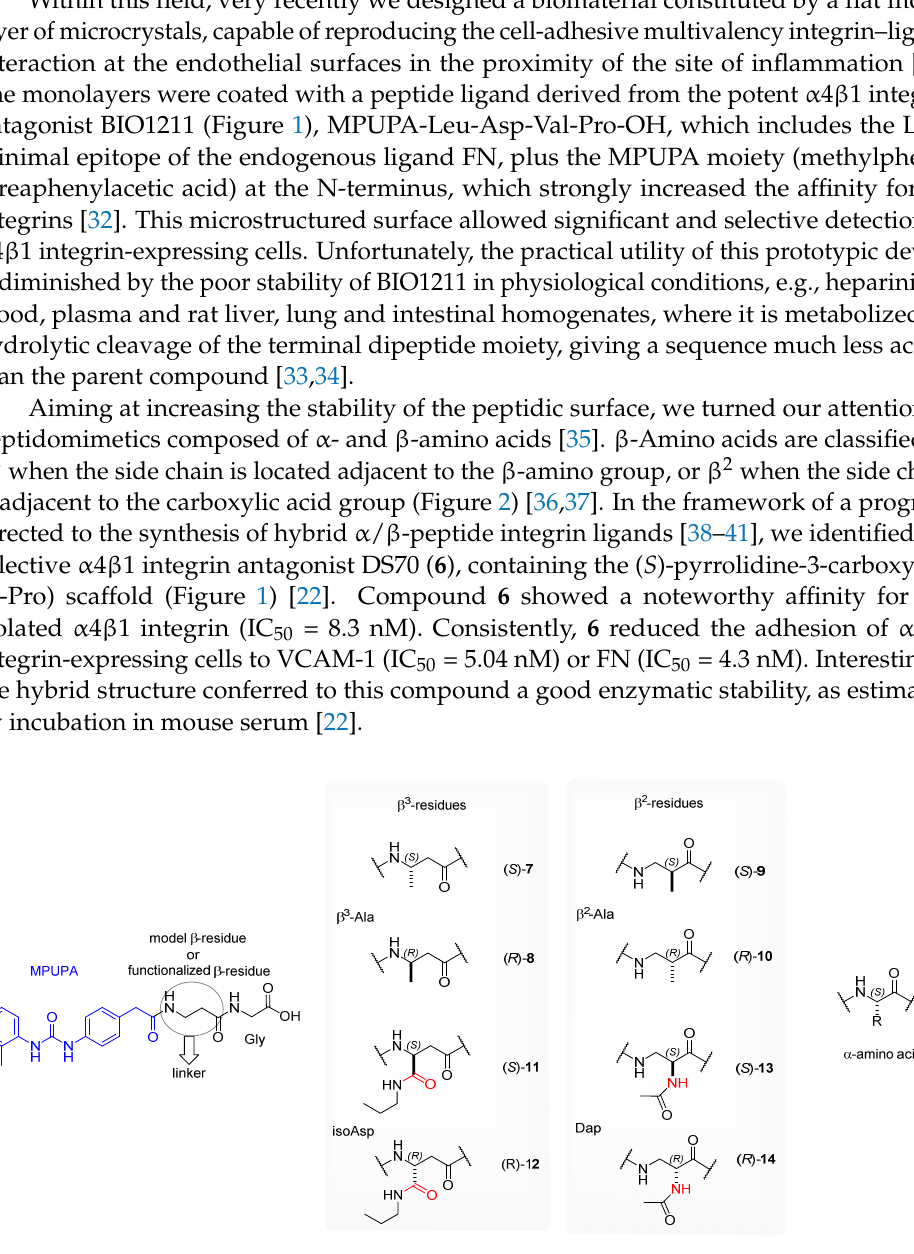
Figure 2. Sketches of candidate α 4 β 1 integrin ligands 7 – 14 based on a hybrid α / β -peptidic structure. In the boxes, model β 3 - or β 2 -aminoacids, i.e., β 3 -Ala and β 2 -Ala, and β 3 - or β 2 -residues carrying side chain functional groups suitable for diverse linker connections, i.e., isoAsp and Dap, respectively, are shown. Functional groups exploitable for peptide conjugation are rendered in red; these are terminated with n-propylamine in 11 and 12 , and with Ac in 13 and 14 . These results prompted us to design analogues of the hybrid α / β -peptide 6 con- taining diverse β -amino acid cores, equipped with versatile functional groups for ex- pedient connection to linkers (Figure 2) suitable for chemoselective functionalization of biocompatible